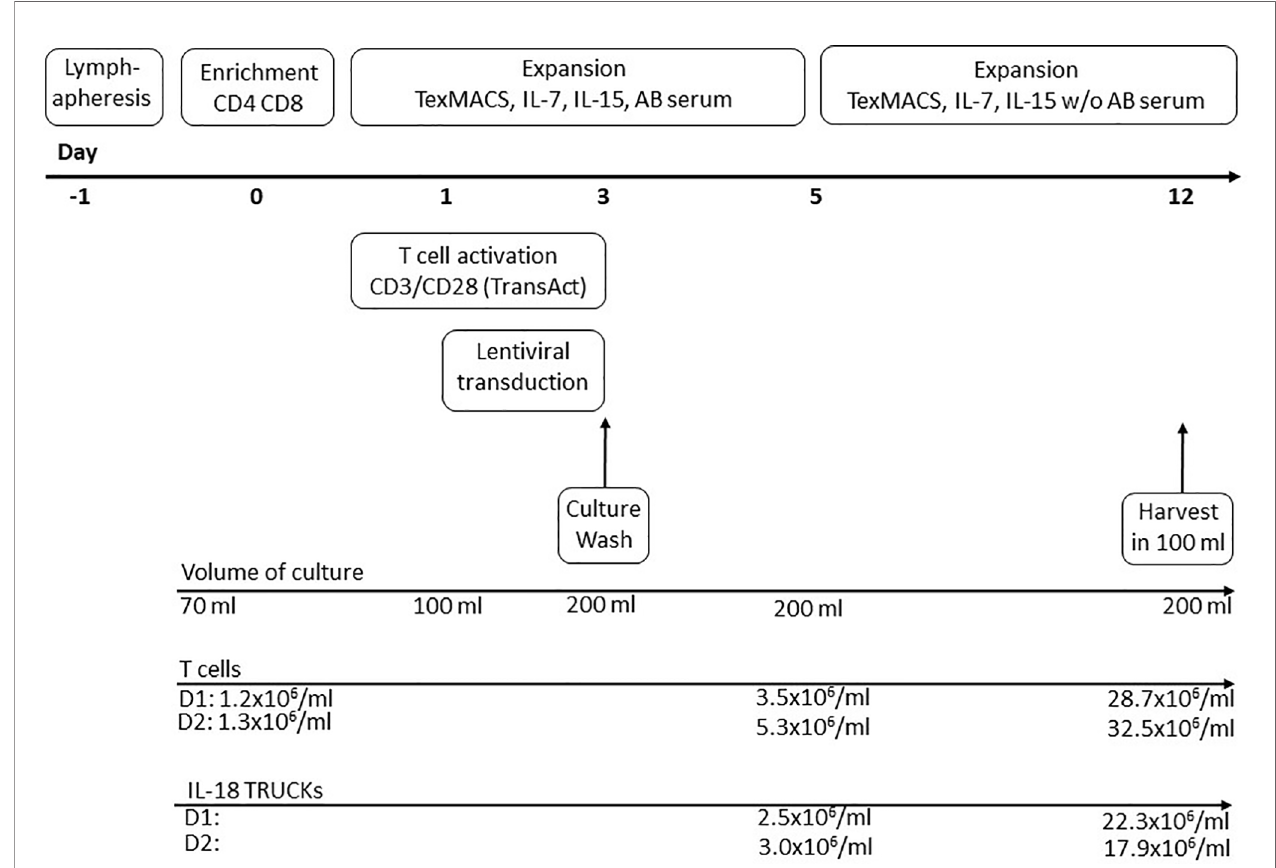
FIGURE 1 | Schematic diagram of producing IL-18 TRUCKs targeting GD 2 utilizing the CliniMACS Prodigy ® automated cell processor (clinical-scale process). The entire 12-day process from lymphapheresis material to formulated fi nal products was performed using the CliniMACS Prodigy ® . Day -1 : Overnight storage of the lymphapheresis at 4°C. Day 0 : Immunomagnetic enrichment of CD4 + and CD8 + cells. Start of T cell activation with CD3/CD28 TransAct Beads (day 0-3) and cultivation in TexMACS ™ basal medium supplemented with IL-7, IL-15 and human AB serum until day 5. Day 1-3 : Lentiviral transduction. Day 3 : Culture wash and start of culture agitation. Day 5 : Switch to TexMACS ™ basal medium supplemented with IL-7, IL-15 without human AB serum for following media exchanges. Day 12 : Wash of cells and harvest in 100 ml formulation buffer for following cryopreservation. During T cell expansion several feeding steps by medium exchange were included in the activity